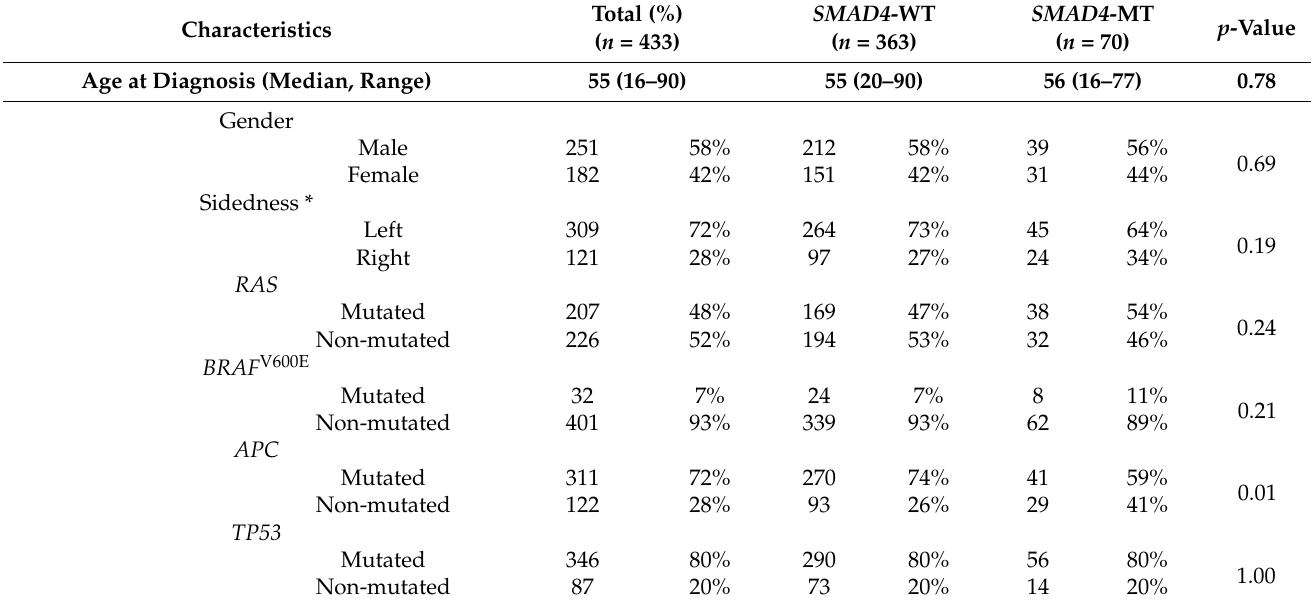
Table 1. Characteristics of patients with metastatic colorectal